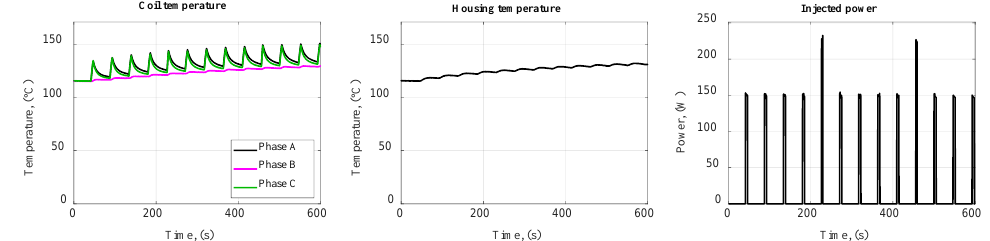
Figure 6. Measured temperatures for one of the two load cycle tests.